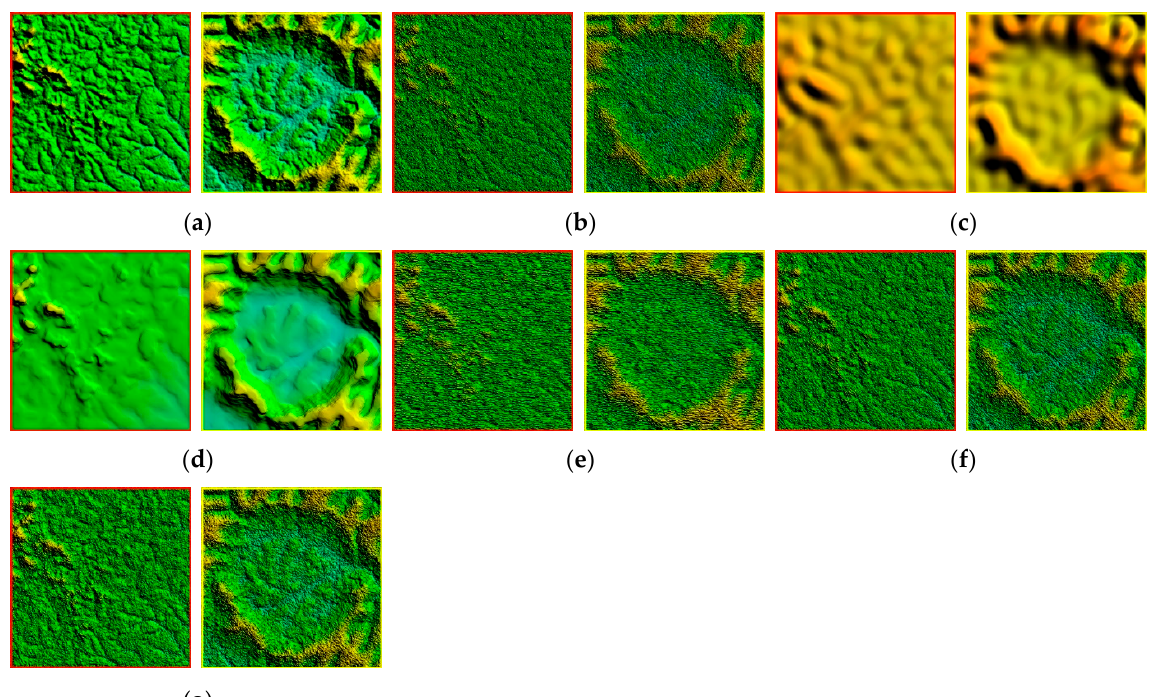
Figure 7. Results of the simulation experiment for area N01E12 with oblique stripes and random-noise mixing errors (unit: meter). ( a ) Original area N01E12, ( b ) mixed error added (29.85, 0.5370), ( c ) low-pass filter (29.13, 0.4297), ( d ) TV (30.65, 0.5400), ( e ) UTV (29.78, 0.5013), ( f ) LRSID (30.26, 0.6259) and ( g ) LRGS (30.60, 0.7213).